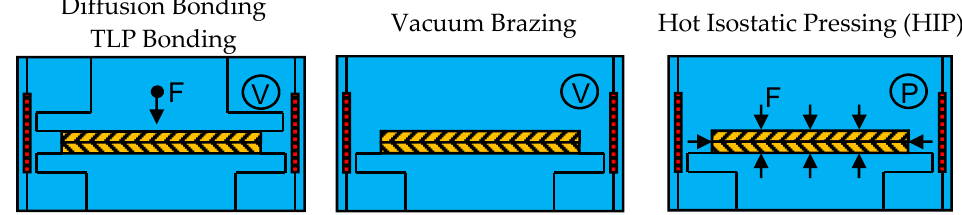
Figure 1. Schematic overview of diffusion bonding and transient liquid bonding (TLP), vacuum brazing and hot isostatic pressing (HIP) as defined in this review.